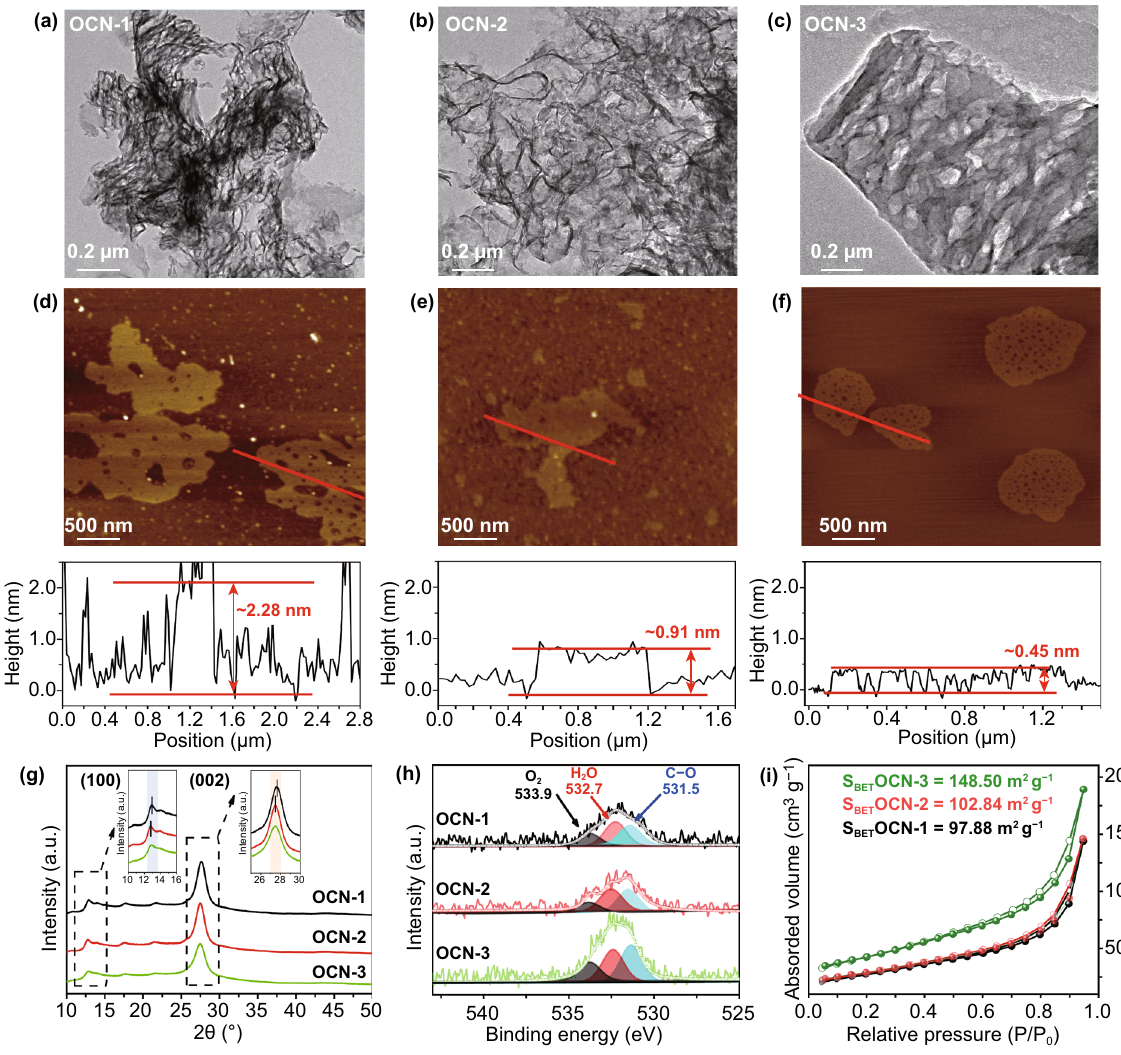
Fig. 2 a – f TEM, AFM images and corresponding height profiles of sample. g–i X-ray diffraction patterns, O 1 s XPS spectra and nitrogen adsorption/desorption isotherms of OCN